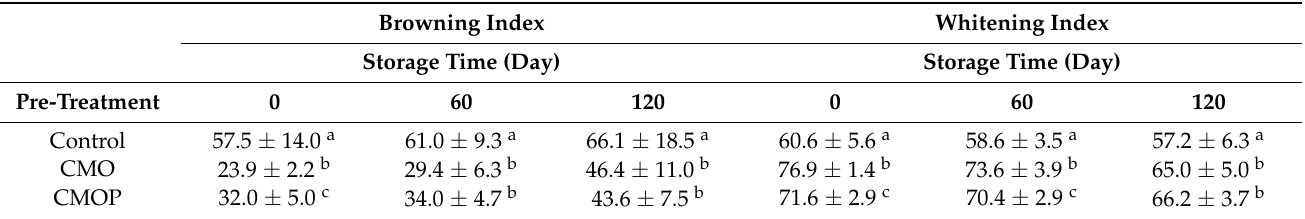
Table 4. Impact of pre-treatment on the colour browning and whitening index of the dried apple slices 1 .